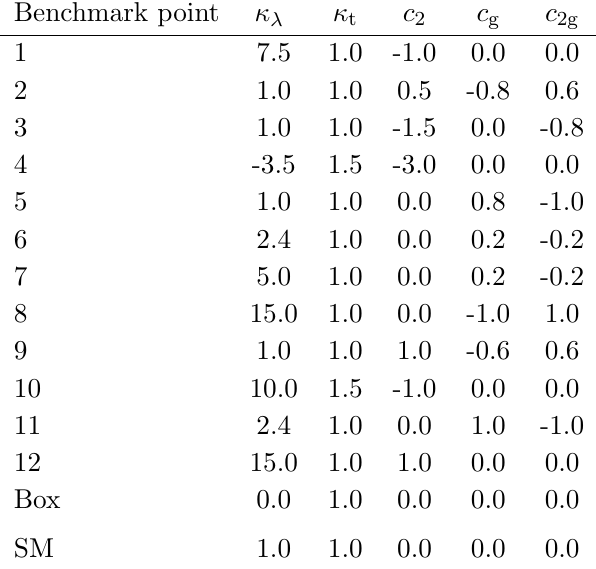
Table 1 . The values of the anomalous coupling parameters for the 13 benchmark models stud- ied [33]. For reference, the values of the parameters in the SM are also